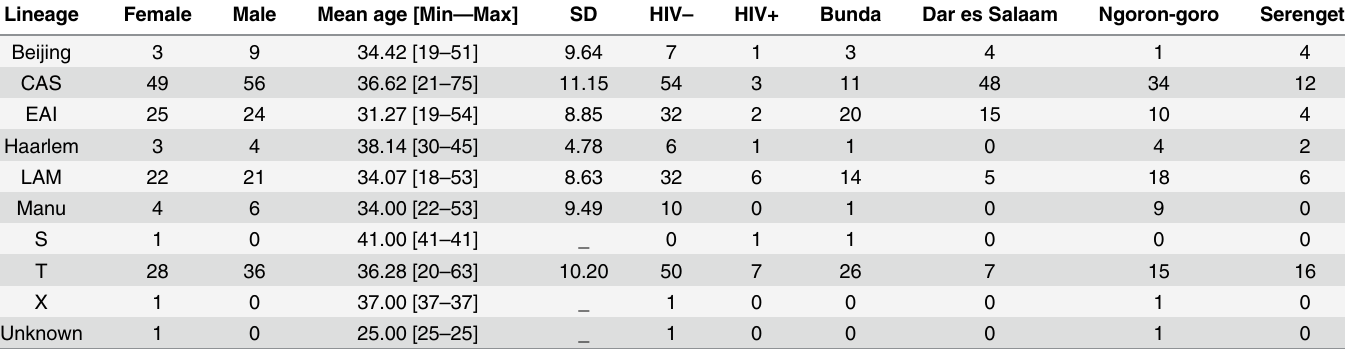
Table 5. Distribution of phylogenetical lineages vs. demographic characteristics of patients and cities of